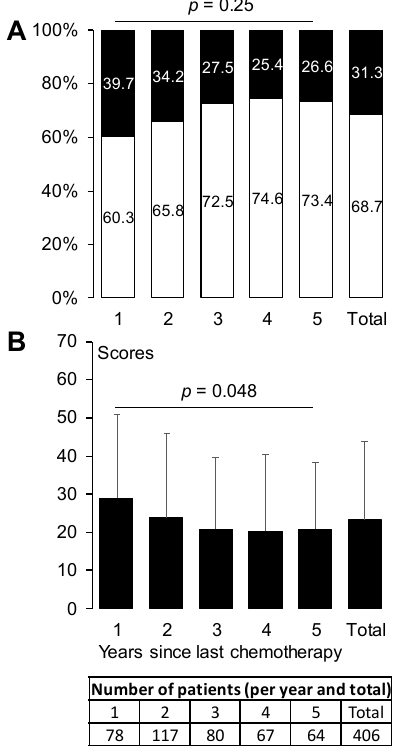
Figure 2. Prevalence of sensory CIPN and QLQ-CIPN20 sensory scores from 1 year until 5 years after chemotherapy end. The prevalence of sensory CIPN ( A ) is expressed as a percentage (white: no CIPN, black: sensory CIPN). The sensory scores ( B ) are expressed as mean ± standard deviation. p -values are provided for global comparison over time (from year 1 to year 5). CIPN, chemotherapy-induced peripheral neuropathy.